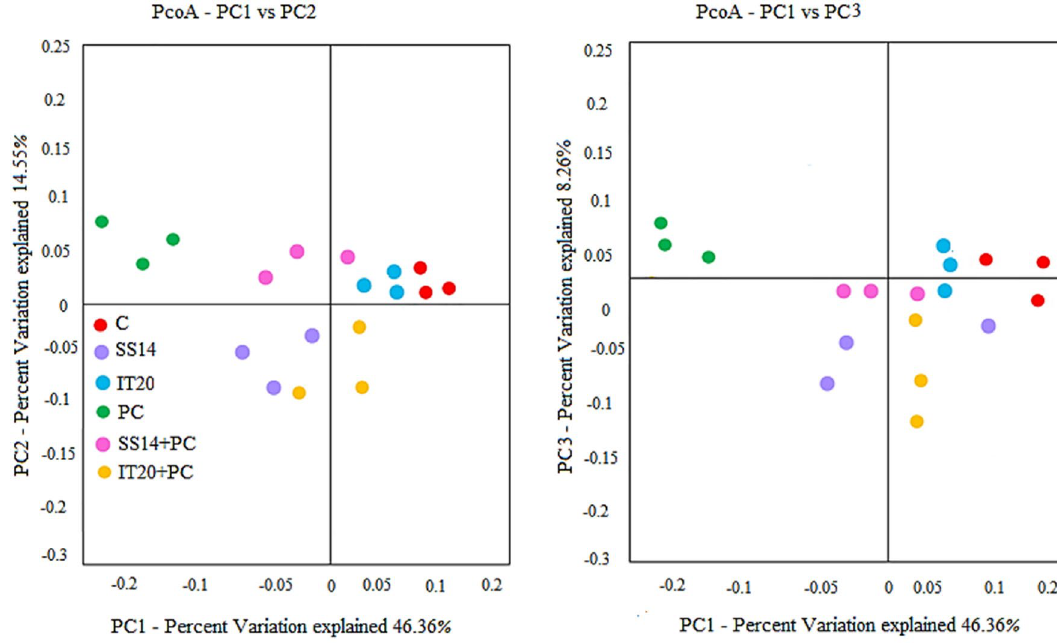
Figure 4. The community clustering is based on Bray–Curtis dissimilarities with weighted UniFrac. Different treatments are indicated with distinct